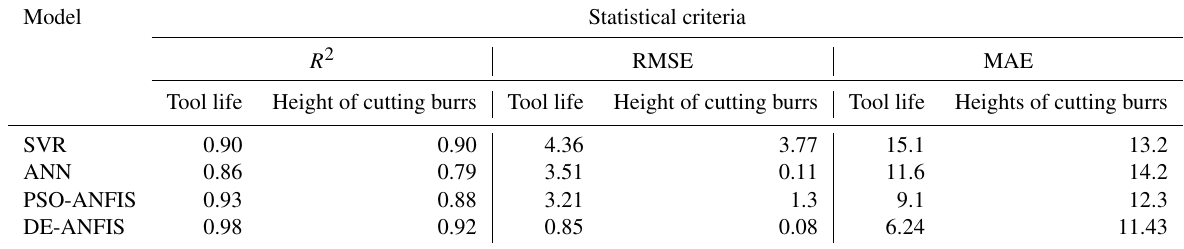
Table 7. Results of statistical criteria in this study.